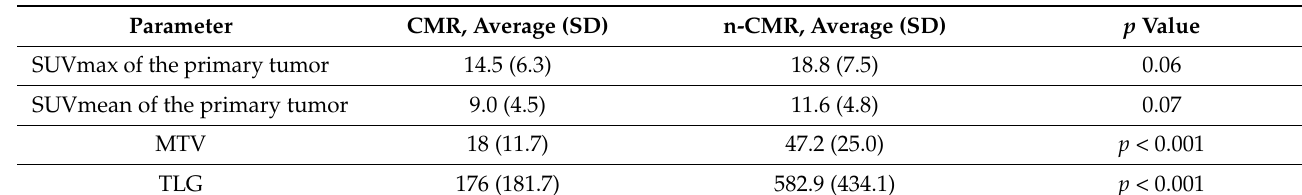
Table 4. Metabolic parameters in CMR and n-CMR groups in patients FIGO stages IB2-IIB.